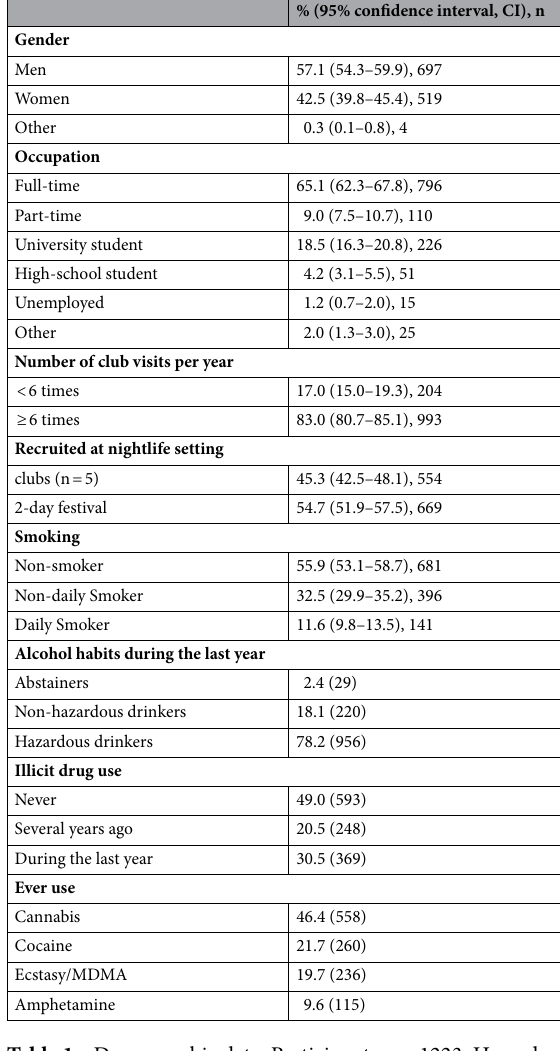
Table 1. Demographic data. Participants, n = 1223. Hazardous drinkers are defined as having a score of at least 4 or 5 points in the Alcohol Use Disorders Identification Test-Concise (AUDIT-C) for women and men, respectively. Data is missing for n = 3 (gender), n = 26 (club visits), n = 5 (smoking), n = 8 (Alcohol habits), n = 13 (Illicit drug use), n = 20 (cannabis), n = 23 (cocaine), n = 22 (ecstasy), and n = 23